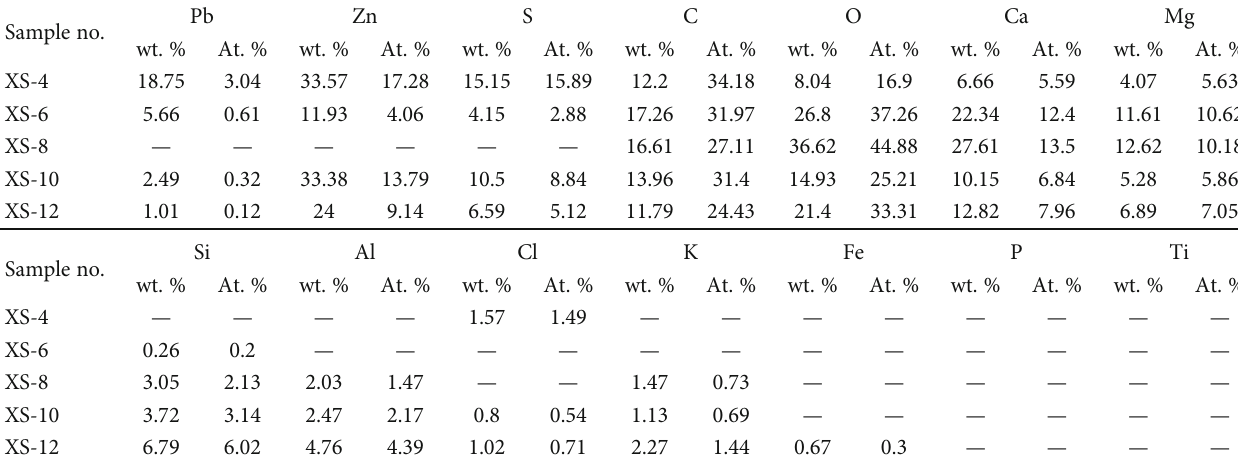
Table 7: EPMA test results.